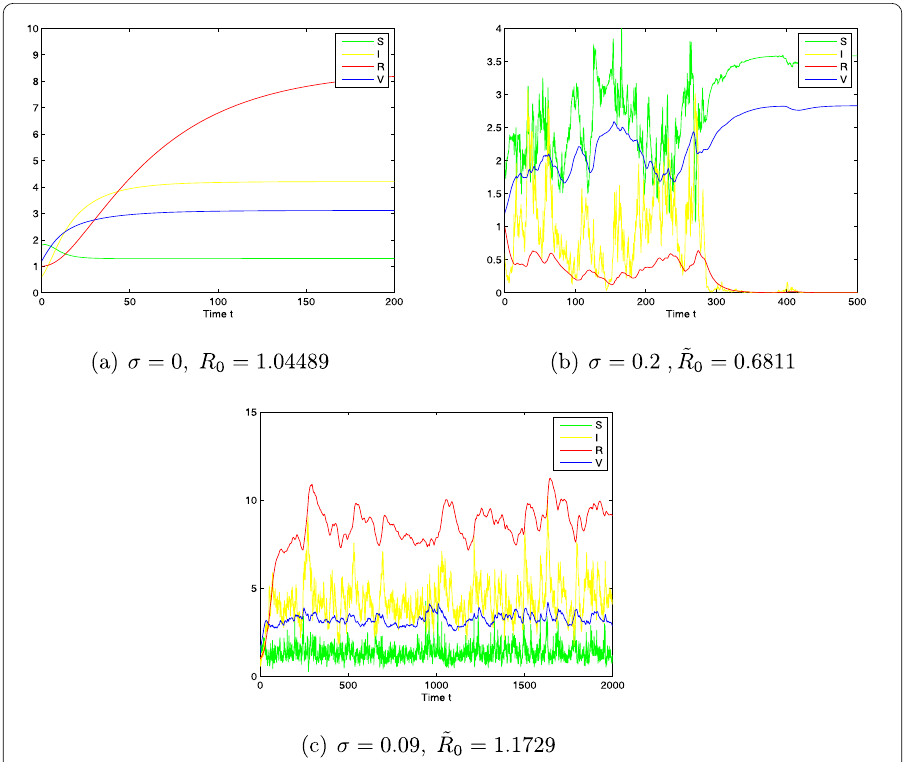
Figure 4 Simulation for paths S ( t ), I ( t ), R ( t ), and V ( t ) for the stochastic system and the corresponding deterministic system with initial value ( S (0), I (0), R (0), V (0)) = (0.5,0.06,0.5,0.5) and step size (cid:26) t =